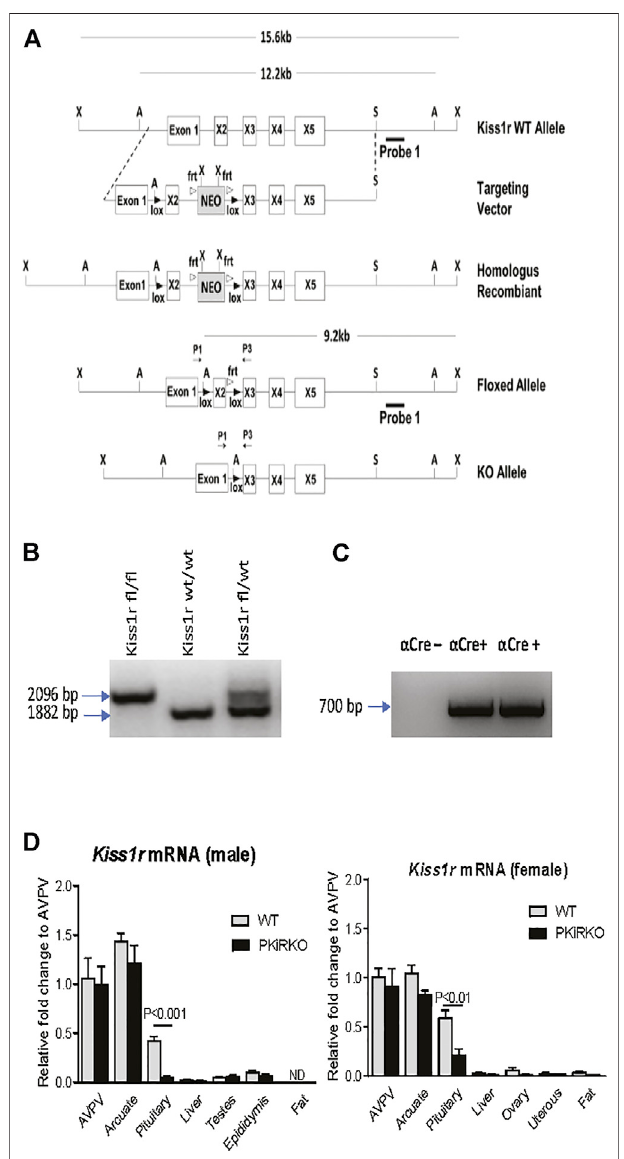
FIGURE 1 | Development of the PKiRKO mouse. (A) schematic diagrams of constructs used to generate PKiRKO mice. Mice bearing LoxP sites fl anking exon 2 of the Kiss1r were crossed with transgenic mice expressing Cre recombinase speci fi cally in Gonadotrophs ( α GSU). (B) Genotyping by PCR analysis of the genomic DNA produced a 2096 bp ampliconinmicewitha fl oxedalleleandan1882bpampliconinkisspeptin fl / fl mice, also shown are both bands present in the heterozygous fl oxed- Kiss1r . (C) Lane 1- α Cre + transgene negative. Lane 2 & 3- α Cre + transgene positive mice. Amplicon size is 700 bp. (D) Quantitative RT-PCR analysis of Kiss1r mRNAextractedfrommaleandfemalemousetissues. Kiss1r wassigni fi cantly reduced (87.6% for male, 63.7% for female) in the pituitary of PKiRKO (KO) mice compared with that in wild type (WT) mice, but no difference in Kiss1r expression was observed in other tissues. ** = p < 0.01. *** = p < 0.001. Data are means ± SEM ( n = 8 for pituitary, n = 4 for other